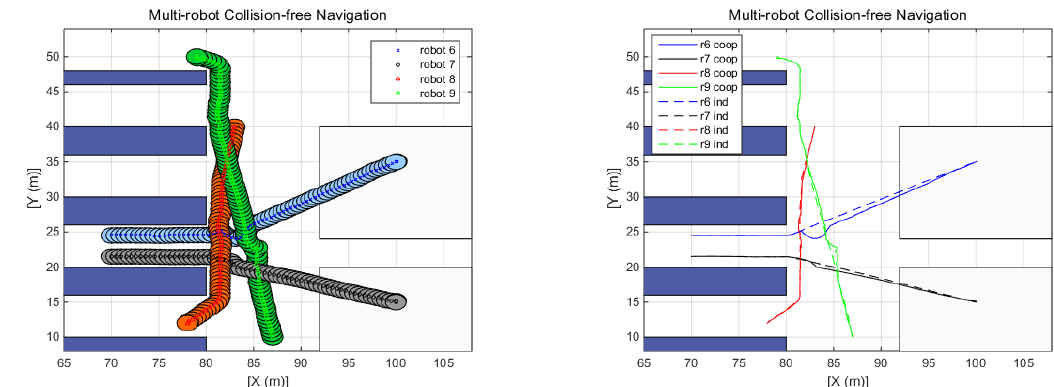
Figure 14. Scenario 3: Four-robot